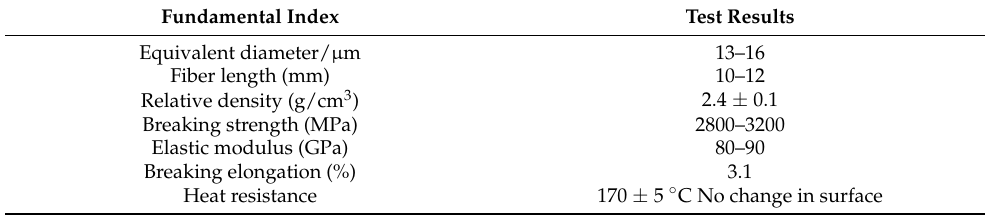
Table 3. Properties of basalt